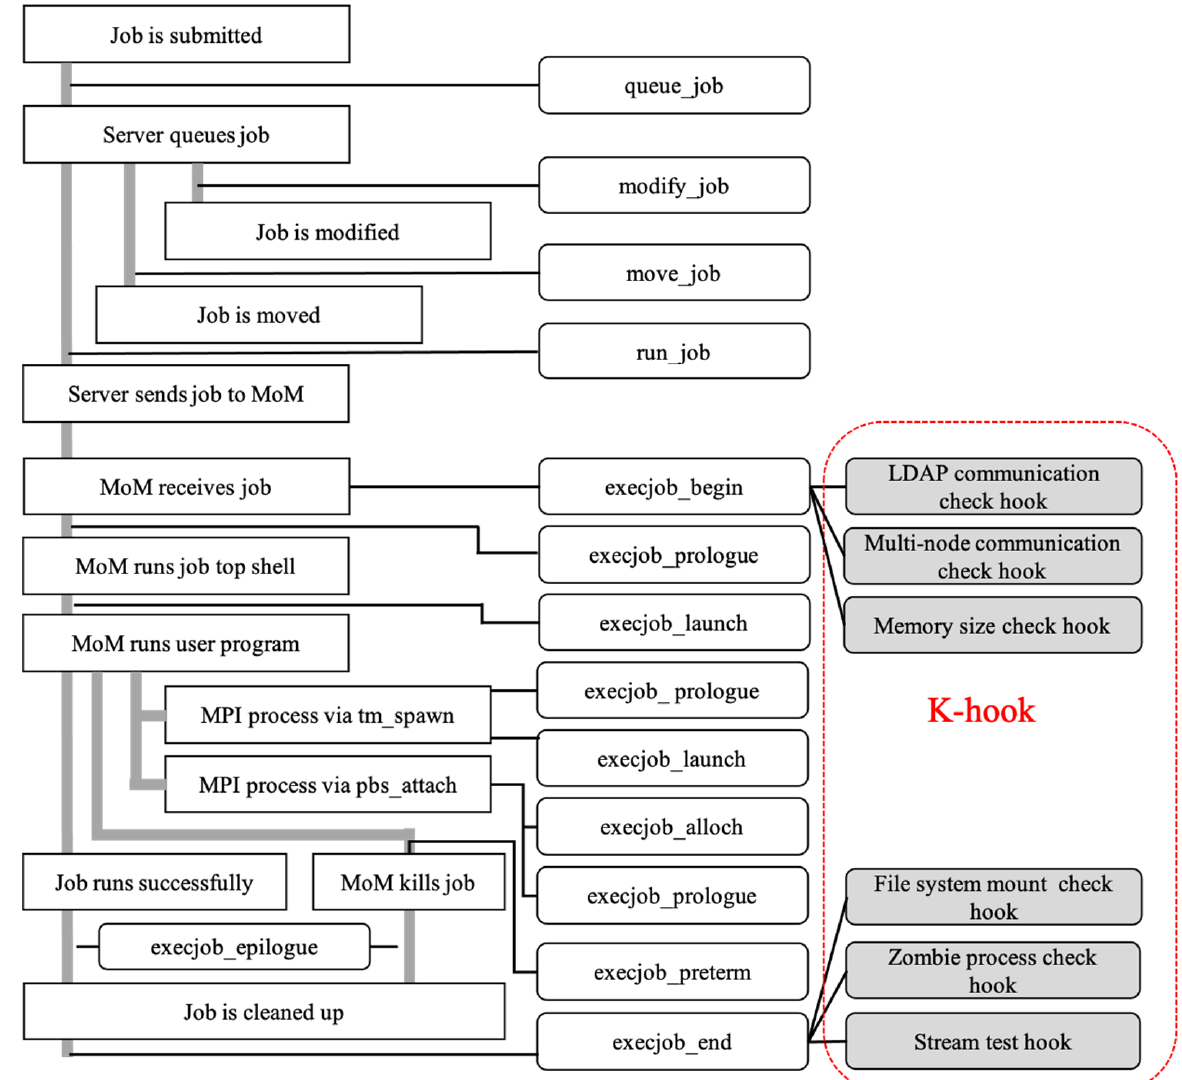
Figure 4. A flowchart of scheduling with K-hook.